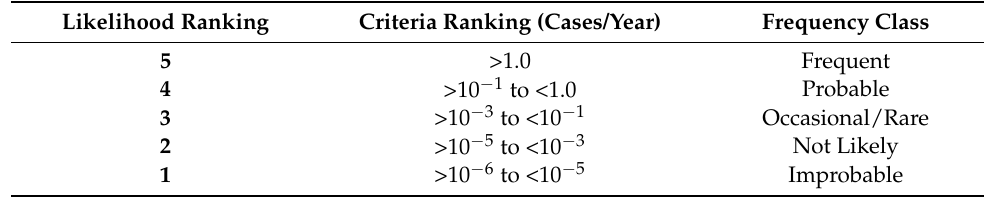
Table 1. Frequency categories and